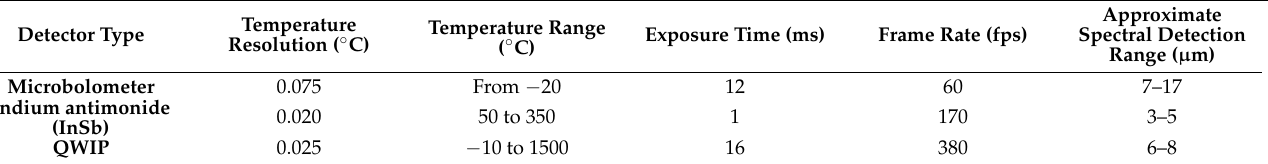
Table 1. Characteristics of the main detector types employed in commercial IR thermography cameras